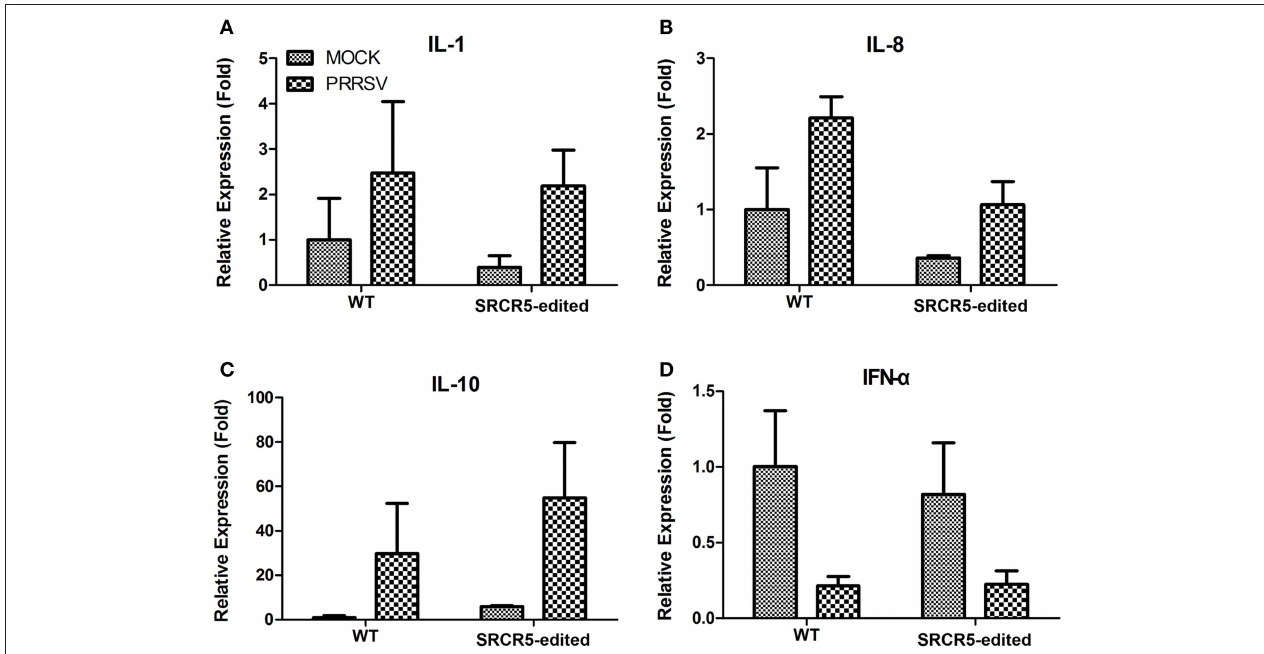
FIGURE 8 | Expression of cytokines in PAMs isolated from CD163 SRCR5-edited piglets. (A–D) CD163 SRCR5-edited PAMs and WT PAMs were either mock infected or infected with JXA1 strain (MOI = 1) for 24h. The expression of inflammatory cytokines IL-1 β (A) , IL-8 (B) , IL-10 (C) , and IFN- α (D) were analyzed using qRT-PCR. Relative expression (fold) in comparison with mock infected WT PAMs (set up as 1) is shown. Data are representative of the results of three independent experiments (means ±